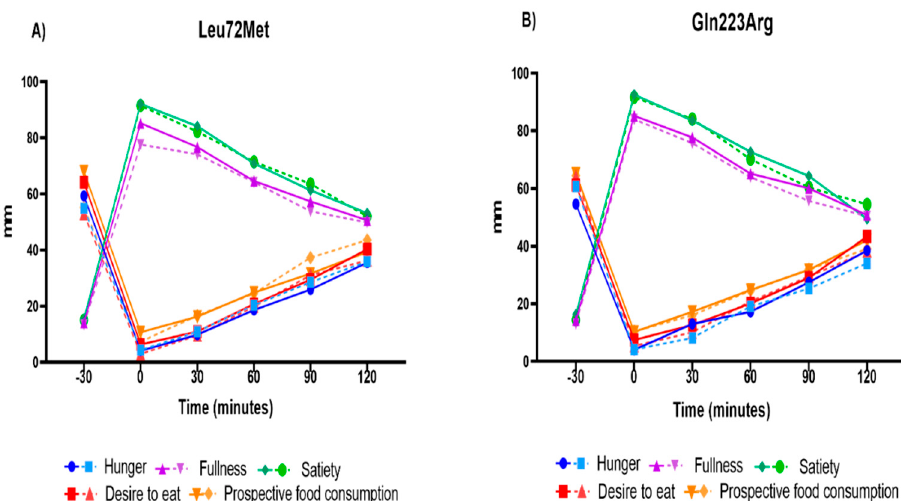
Figure 4. Subjective appetite by polymorphism Leu72Met of GHRL and Gln223Arg of LEPR genes. Graph ( A ) shows the comparison of the five subjective aspects of appetite between the Leu72Met genotypes. Graph ( B ) shows the comparison of the same variables between the Gln223Arg genotypes. A two-way repeated-measures ANOVA (analysis of variance) was used to compare time x genotype interaction for the subjective aspects of appetite. A p -value < 0.05 was considered statistically significant. The continuous line represents the homozygous genotype; the dashed line represents the heterozygous/homozygous polymorphic genotypes of Leu72Met of GHRL and Gln223Ag of LEPR genes, respectively.